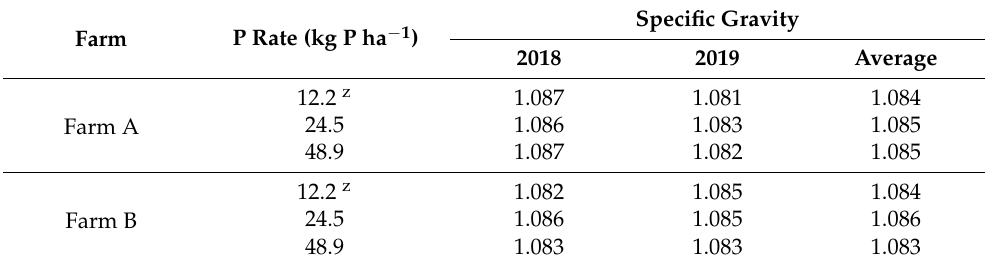
Table 8. Specific gravity of ‘Atlantic’ chipping potato grown on Farm A and B with different P fertilizer applications in the years 2018 and 2019. There was not any statistically significant difference in specific gravity between the P